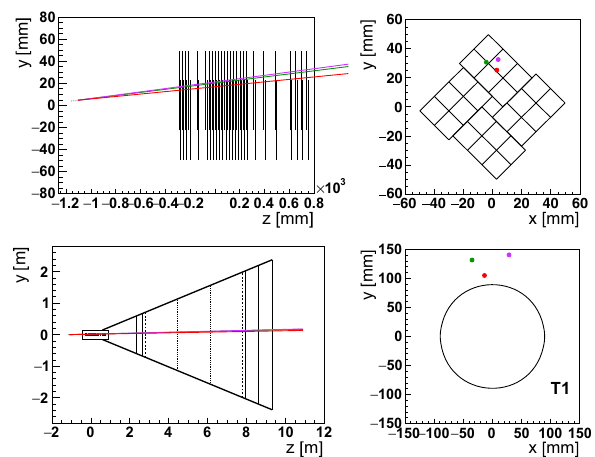
Fig. 8 Sketch of a fixed-target Λ + c → pK − π + event generated with Pythia at position ( 0 , 0 . 4 , − 116 ) cm with a crystal bending θ = 14mrad, as seen by the simplified LHCb detector geometry C model based on Refs. [61,62] with a conservative beam clearance of the downstream stations of 30mm. The first VELO module is located at z ≈ − 29cm, upstream of the nominal LHC collision point at z = 0. The points represent the hits of the proton (green), pion (violet) and kaon (red) tracks overlaid in the (top left) side view of the VELO, (top right) front of the last VELO module, (bottom left) schematic side view of the whole LHCb detector, and (bottom right) central area of the T1 station. Events are considered within acceptance when they cross at least three VELO modules and the three T stations. The track bending due to the LHCb dipole magnet is taken into